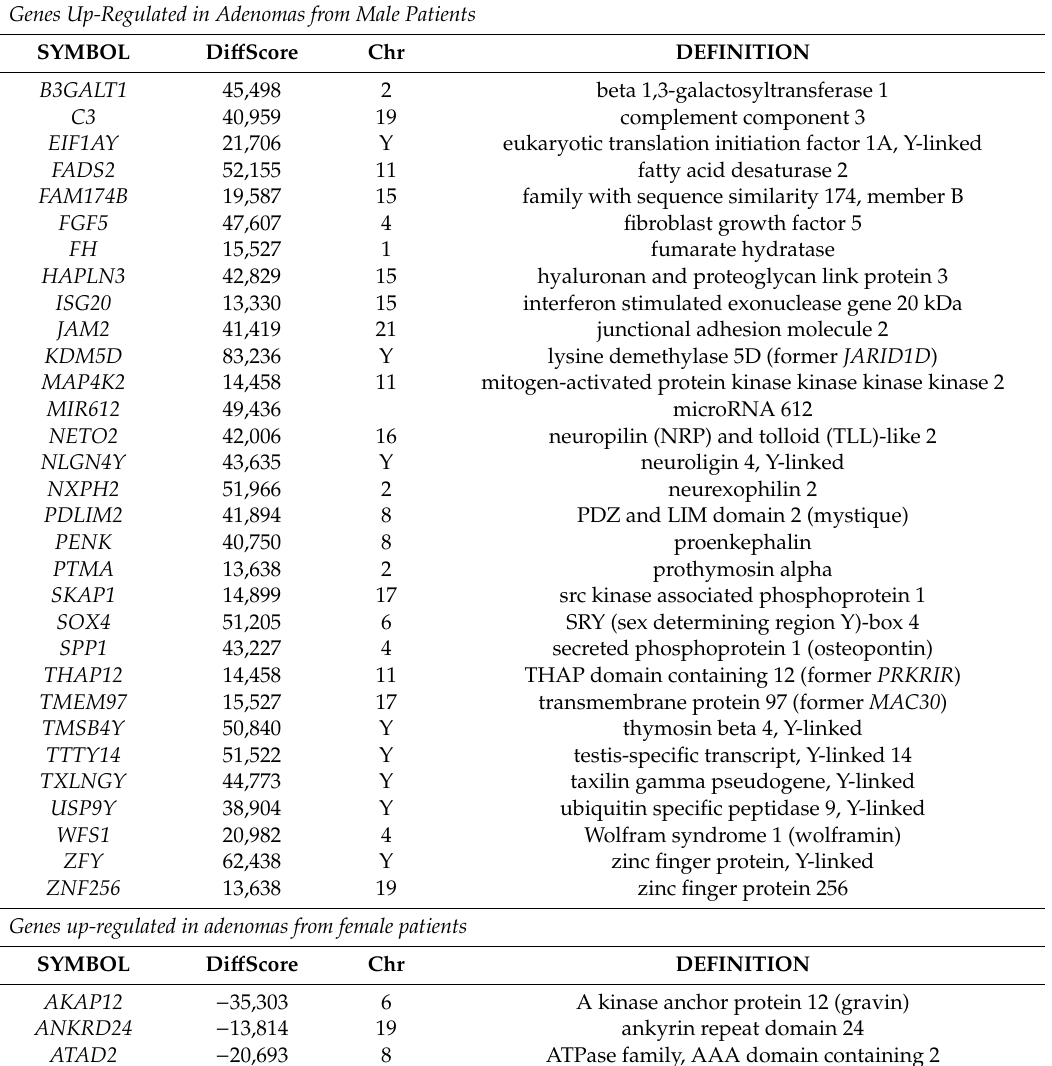
Table 4. Genes di ff erentially regulated according to